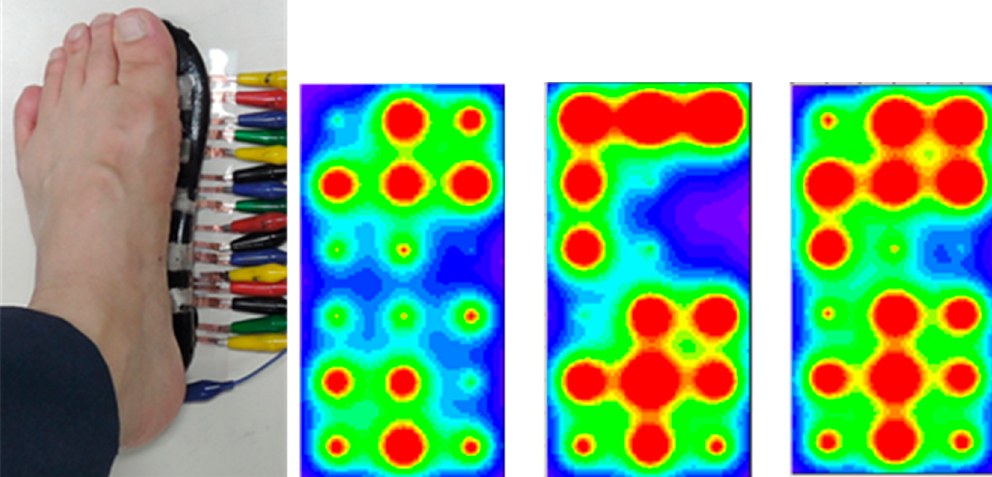
Figure 13 . Human plantar measurement photo and the calibrated images of different foot pressure states with k value of 0.18.